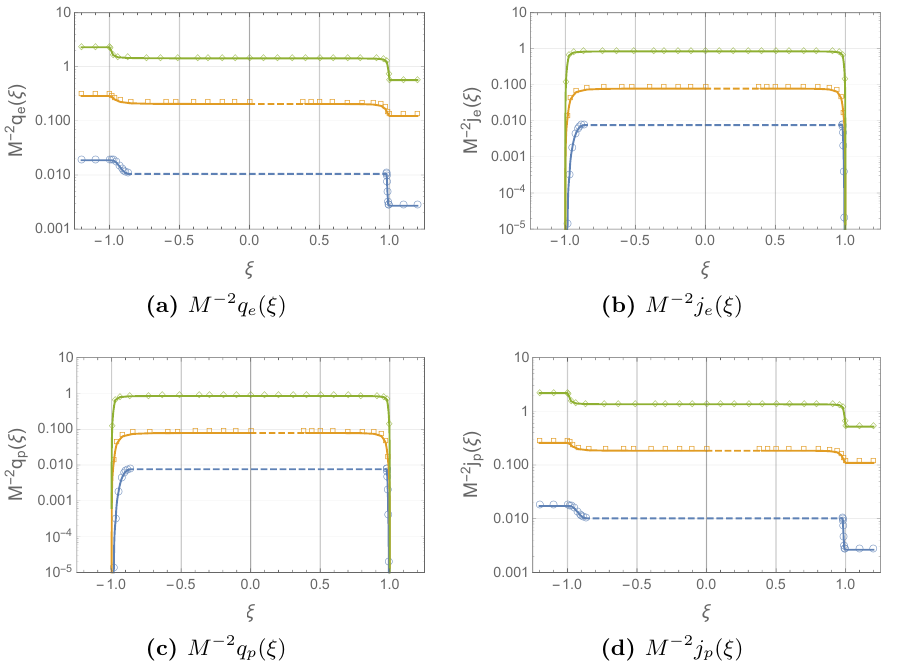
Figure 4. Ray-dependent (a) energy density q e , (b) energy current j e , (c) momentum density q p and (d) momentum current j p in the A 2 tricritical to critical Ising (cid:13)ow after bipartite quenches at the Euler scale. The green curve with diamonds corresponds to left and right initial temperatures T l = 2 : 5 M and T r = 1 : 25 M , the orange curve with squares to T l = 0 : 9 M and T r = 0 : 6 M and the blue curve with circles to T l = 0 : 25 M and T r = 0 : 1 M . The discrete points in the plots indicated by the plotmarkers are obtained by the numerical solution of GHD equations, the continuous curves are (cid:12)rst order interpolations. The dashed part of the curves indicates the region of constant densities and currents. Due to relativistic invariance, j e = q p